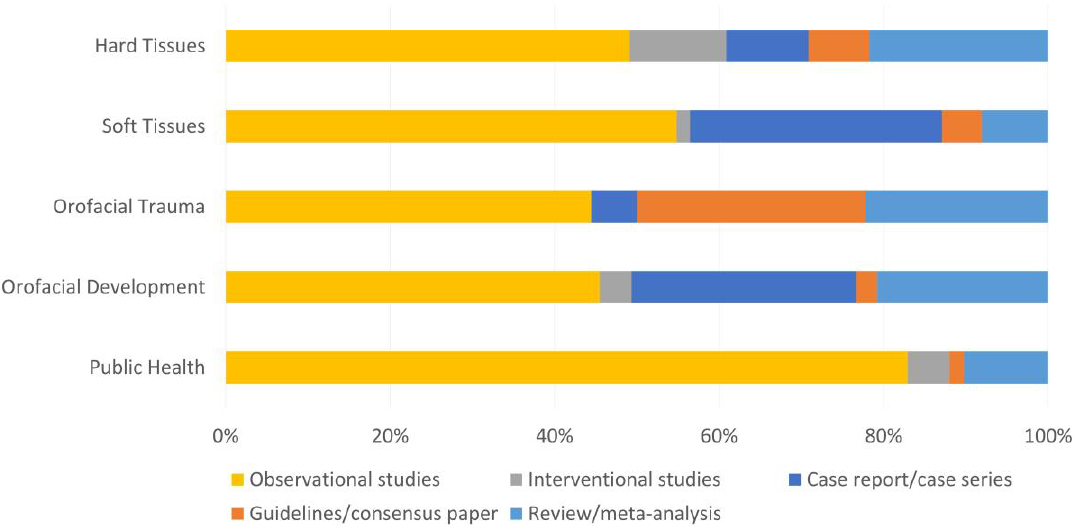
Figure 2. Type of studies of the included papers in different dental areas .